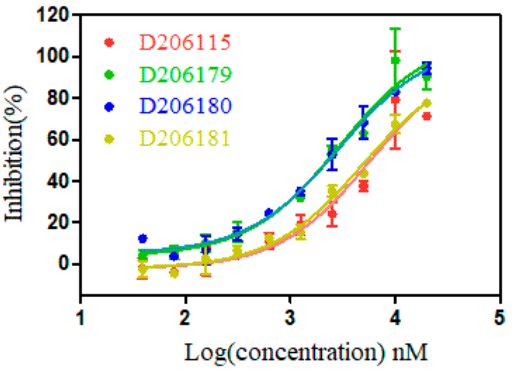
Table 4. Data from direct FP binding experiments; N.D.: not determined; The results are presented as mean ± standard error